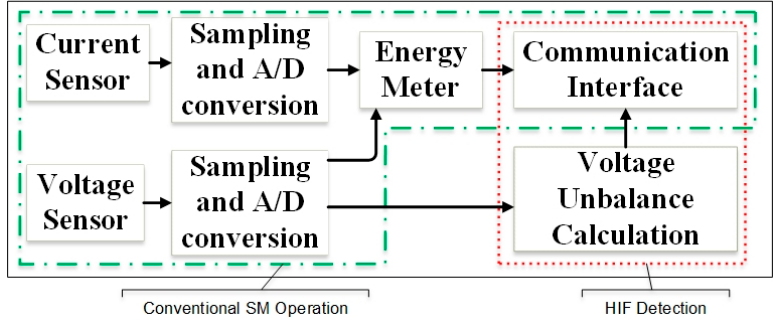
Figure 2. Smart meter (SM) diagram with new functionality for HIF detection.